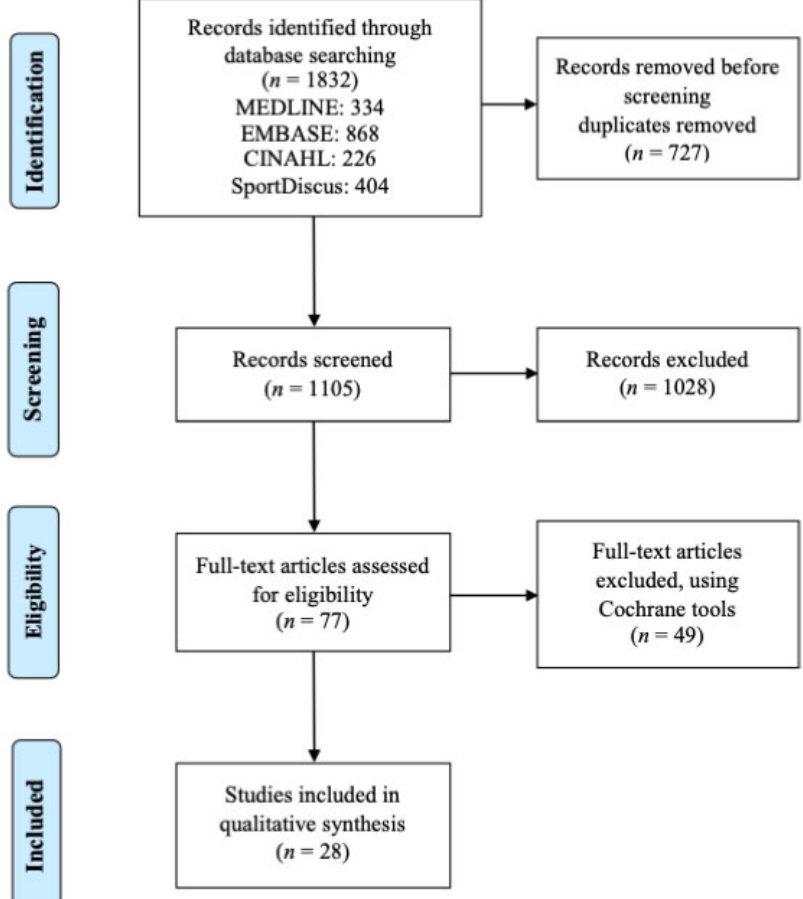
Figure 1. The Preferred Reporting Items for Systematic reviews and Meta-Analyses flow chart.